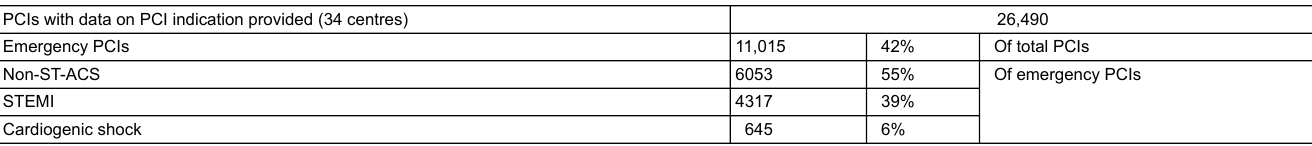
Table 4: Indication for percutaneous coronary intervention. PCIs with data on PCI indication provided (34 centres)